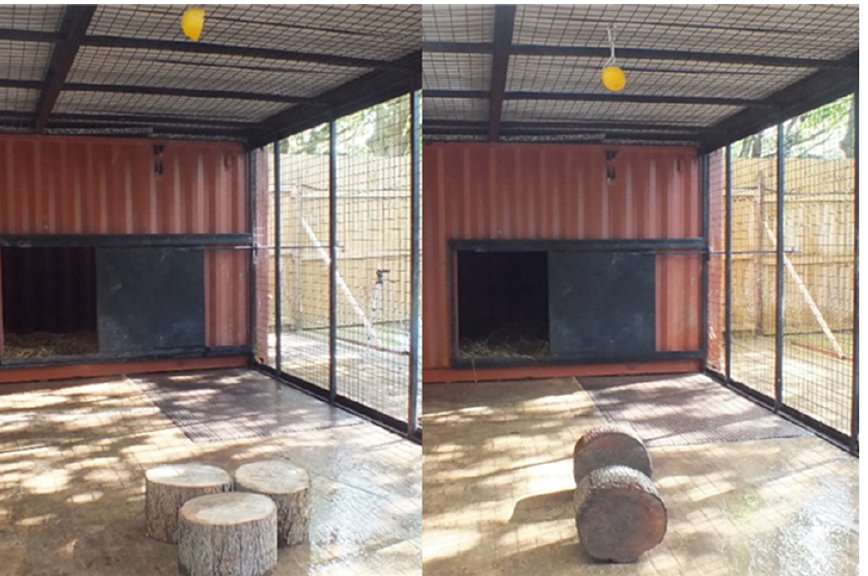
Object-Manipulation Stages One and Two. Photo credit: Chambers,